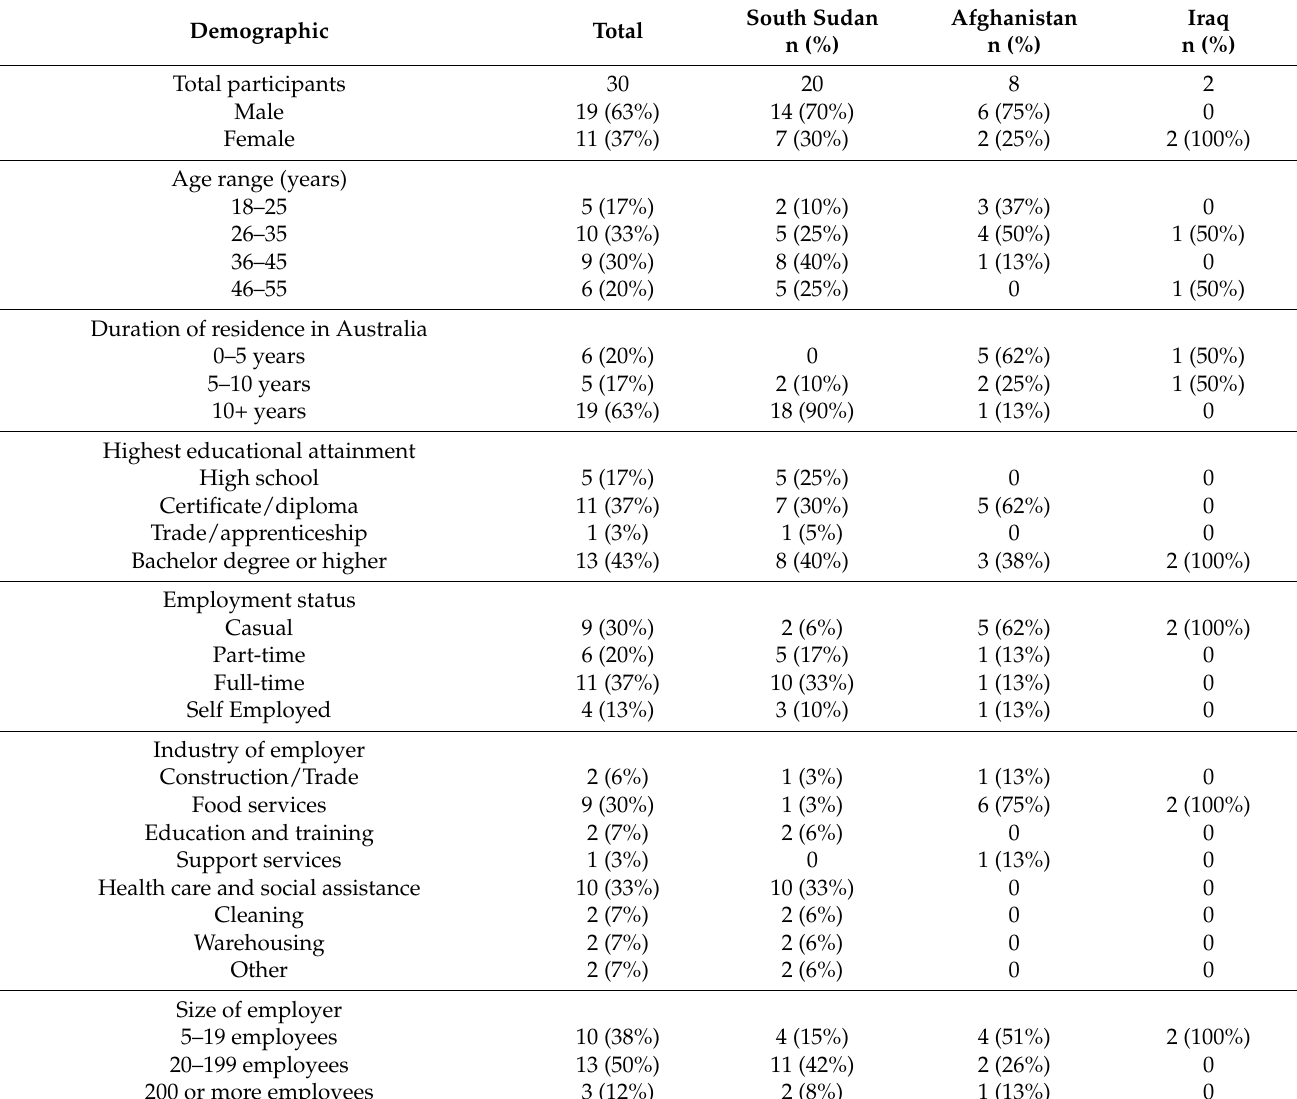
Table 2. Participants’ socio-demographic and employment characteristics by country of